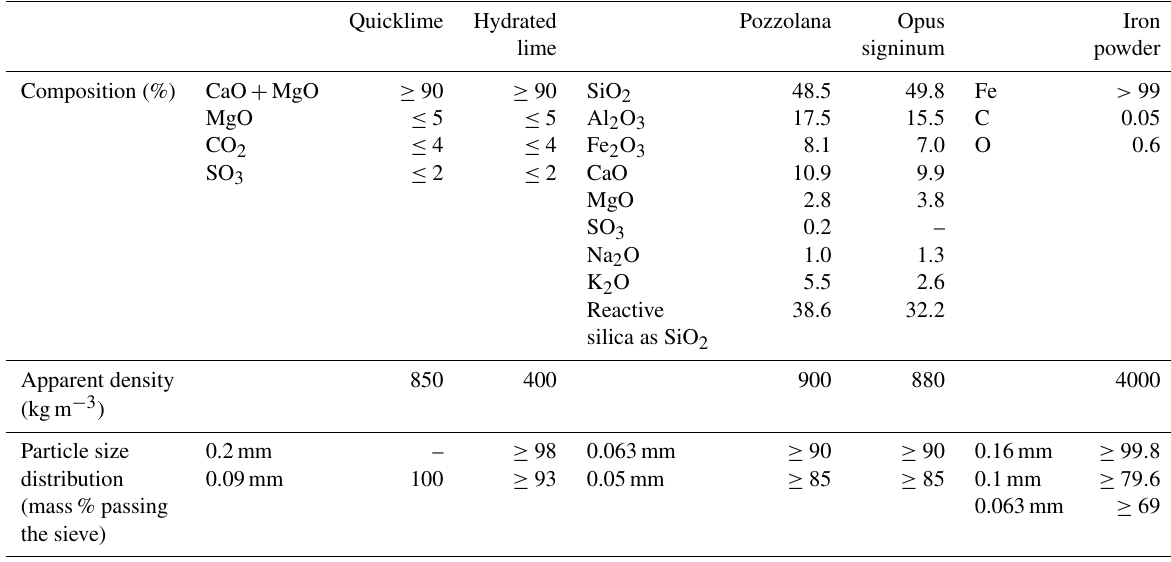
Table 1. Composition, apparent density, and particle size distribution of raw materials. Quicklime Hydrated Pozzolana Opus